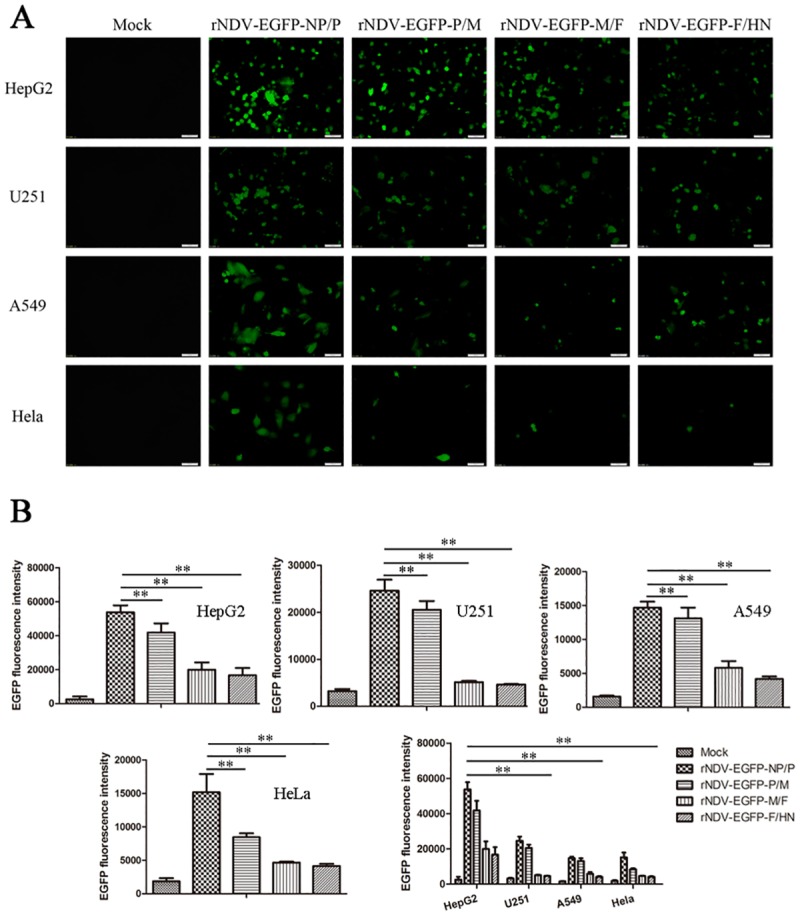
(A) Rescued viruses stably express EGFP in different tumor cells. rNDV-EGFPs at MOI of 10 were used to infect tumor cells in 6-well plate. At 48 hpi, the fluorescence in the infected cells were detected and digitally photographed by fluorescence microscopy. The white bar represents 20 μm. (B) Measurement of EGFP fluorescence intensity. Tumor cells in 6-well plate were mock-infected or infected with rNDV-EGFPs at MOI of 10 for 48 h, and EGFP fluorescence intensity were analyzed using flow cytometry. The results were expressed as the quantity of the mean EGFP fluorescence cells with SEM (* P < 0.05; ** P < 0.01).